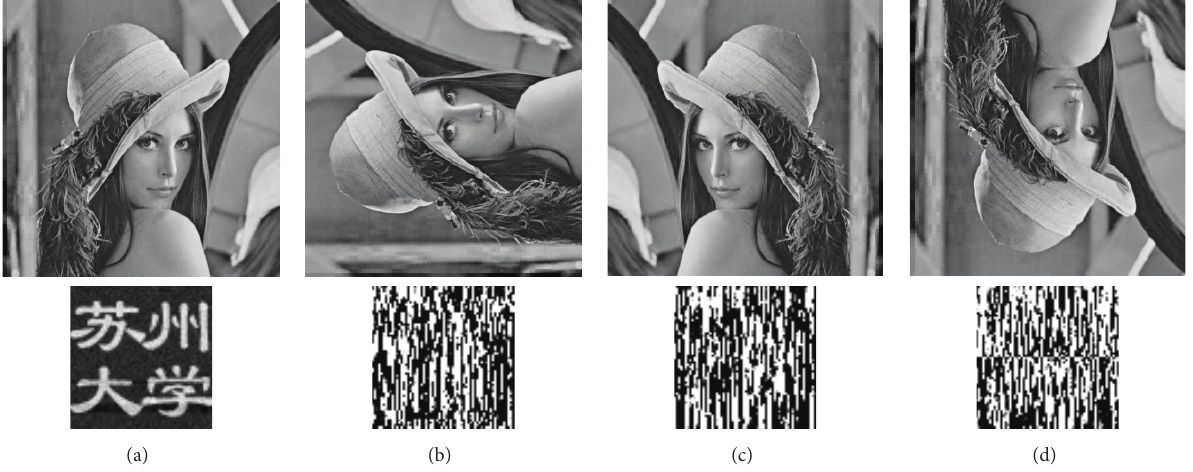
Figure 3: Watermarked, distorted watermarked, and extracted watermark images.